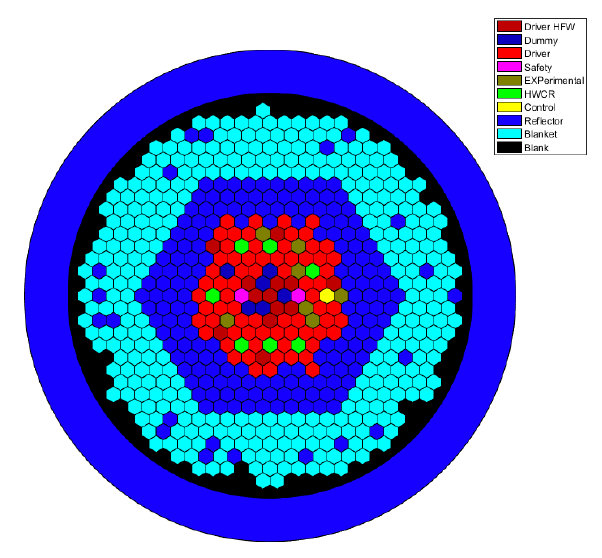
Figure 1. EBR-II Run 138B core configuration [1].